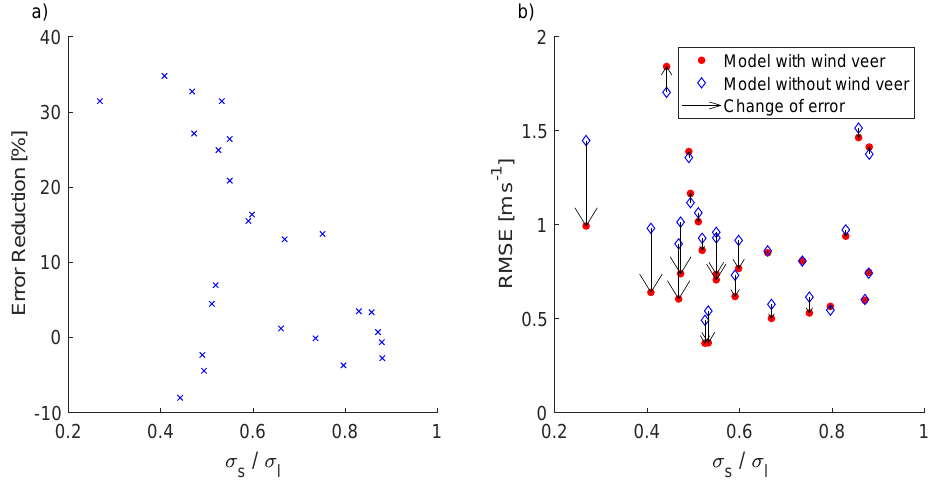
Figure 9. Percentage of the error reduction between model and measurements by including the effect of wind veer to the model as a function of the wake’s circularity ( a ) and the reduction of the root-mean-square-error ( b ). Percentage values are based on the error of the model without the effect of wind